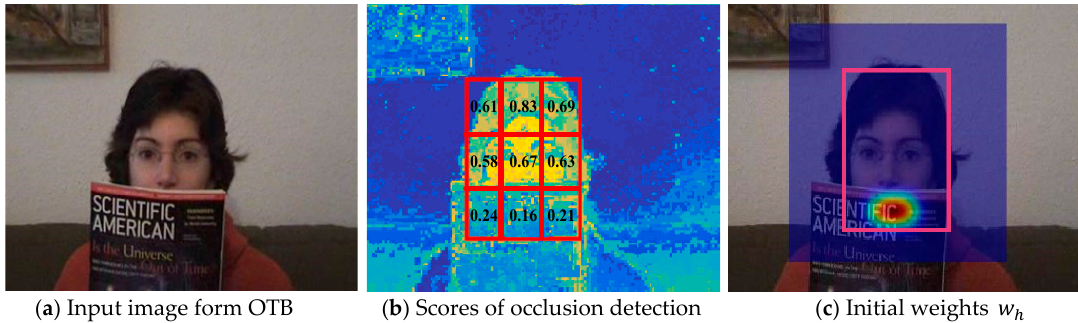
Figure 2. Constructing anisotropic weight constraints based on occlusion detection.